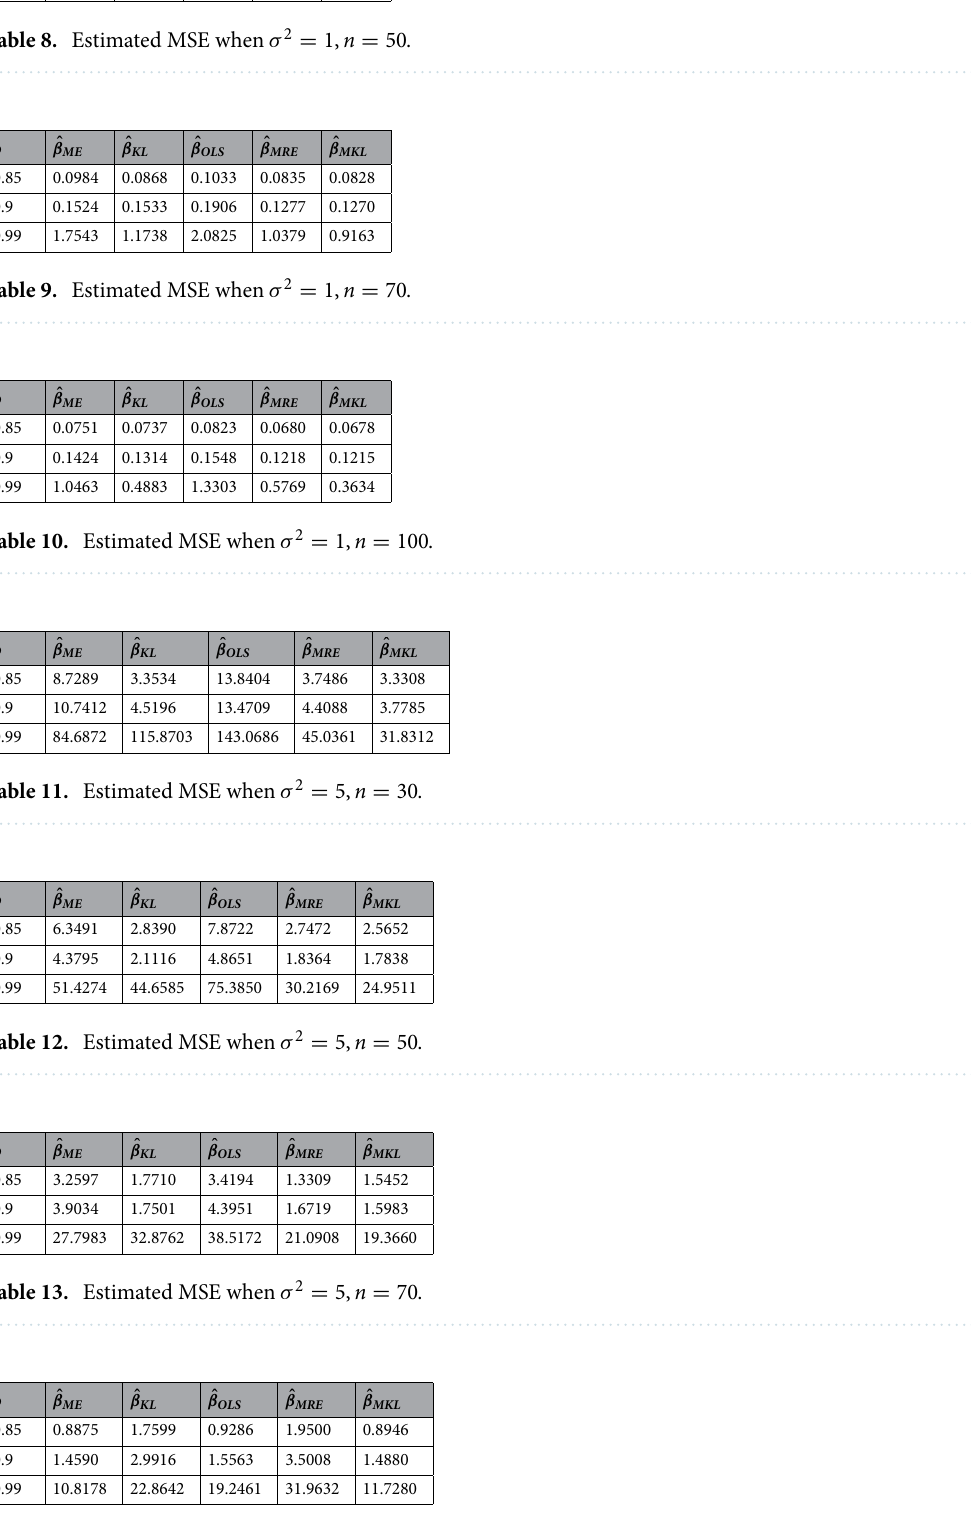
Table 14. Estimated MSE when σ